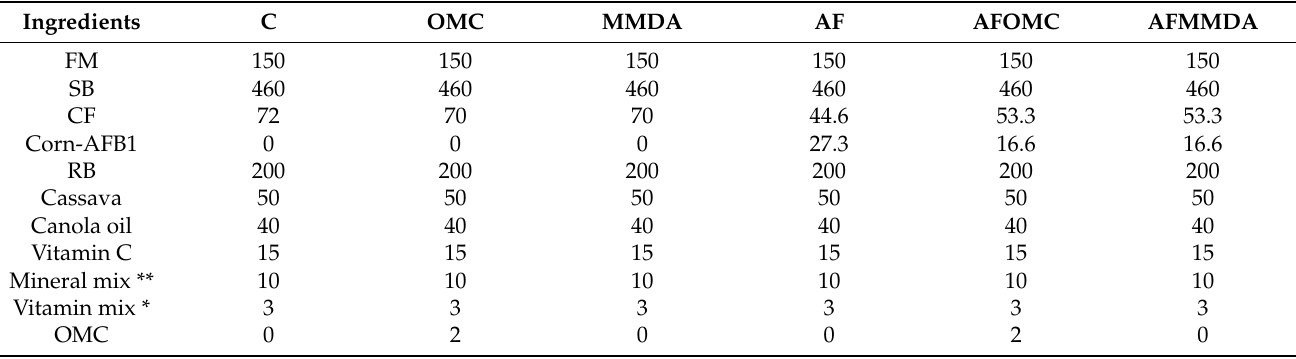
Table 1. Ingredients (g/1000 g based on dry diets) and chemical composition (% on dry matter basis) of the experimental